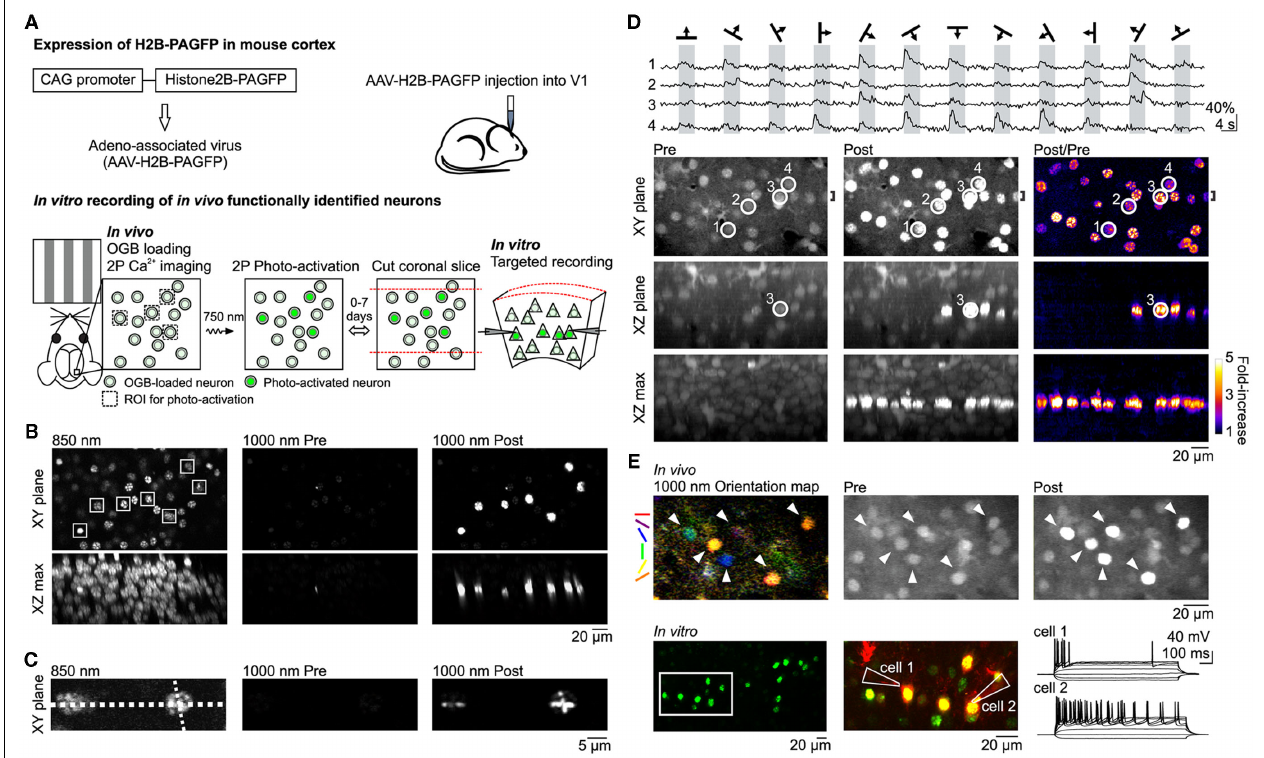
column) photo-activation of the entire imaging plane as well as the fold-increase in fluorescence (right column).Top row shows the XY plane. XZ plane (center row) and XZ max (bottom raw) images are maximum intensity projections through the region indicated by the bracket (shown on top row) and the entire field of view, respectively. (E) In vitro whole-cell recording of neurons functionally characterized and photo-activated in vivo . (Top) Orientation map shows the responsiveness and orientation tuning of each pixel in response to drifting gratings.Visually responsive neurons (arrowheads) were targeted for photo-activation. (Bottom) Green photo-activated neurons in an acute coronal brain slice from the region imaged in vivo .Two neurons in the region indicated by the white rectangle were targeted for whole-cell recording. Middle panel shows the photo-activated neurons in green and Alexa 594 dye, which was included in the internal solution of the patch pipettes, in red.The membrane potential response to hyperpolarizing and depolarizing current steps is shown to the